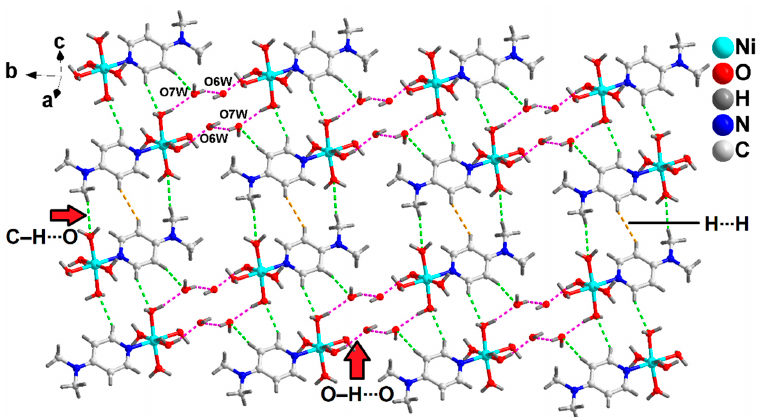
Figure 4. Layered assembly of compound 1 along the crystallographic bc plane assisted by lattice water molecules.